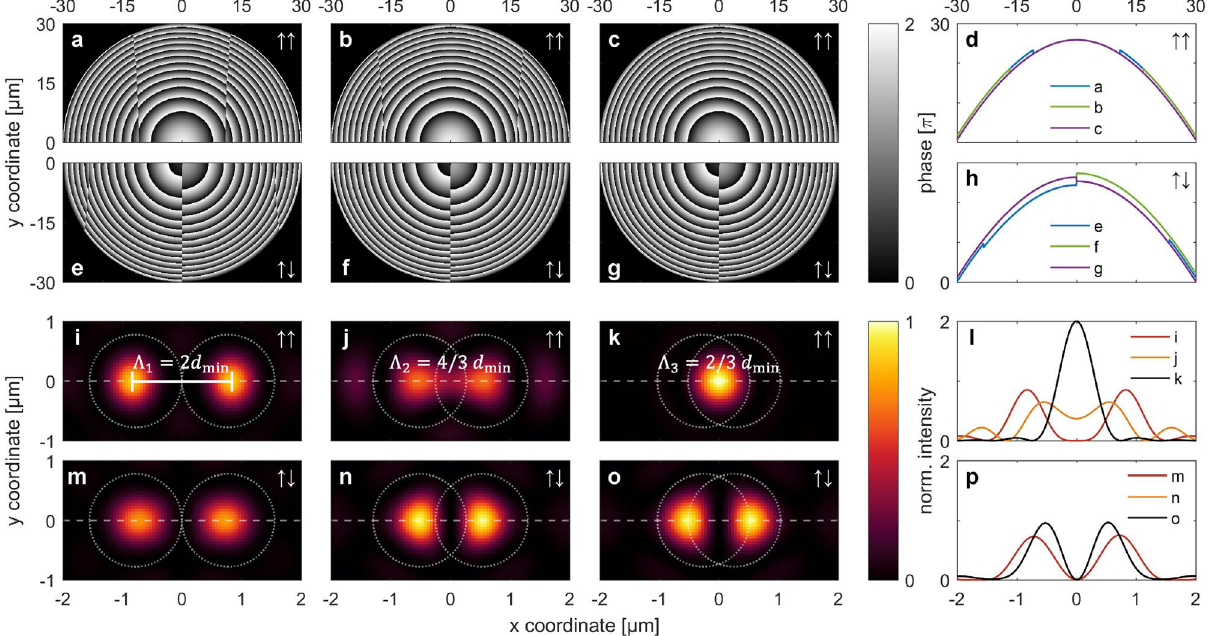
Figure 2. Comparison of in-phase ( ↑↑ ) and opposite-phase ( ↑↓ ) configuration for the situation of two foci ( N = 2) for different inter-focal distances Λ . ( a )–( c ) Phase holograms in the aperture plane ( z = 0) for the ↑↑ case: ( a ) Λ 1 = 2 d min , ( b ) Λ 2 = 4/3 d min , ( c ) Λ 3 = 2/3 d min , together with their unwrapped phase profiles (having the 2π modulus removed) along y = 0 shown in ( d ). ( e )–( h ) Respective phase distributions for the ↑↓ scenario. ( i )–( k ) Intensity distributions in the focal plane ( z = f ) obtained from the holograms shown in ( a )–( c ) ( ↑↑ case). (l) Corresponding profiles along y = 0 direction (horizontal dashed lines in ( i )–( k )). ( m )–( p ) Corresponding distributions for the ↑↓ case (scenarios ( e )–( h )). Note that the yellow curve in (p) is identical to and lies underneath the black curve. The maximum intensity ( I 0 ) of all double focus distributions was used for normalization of the data in ( i ), ( j ), and ( l )–( p ). For better visibility, the data in ( k ) were normalized by 2 I 0